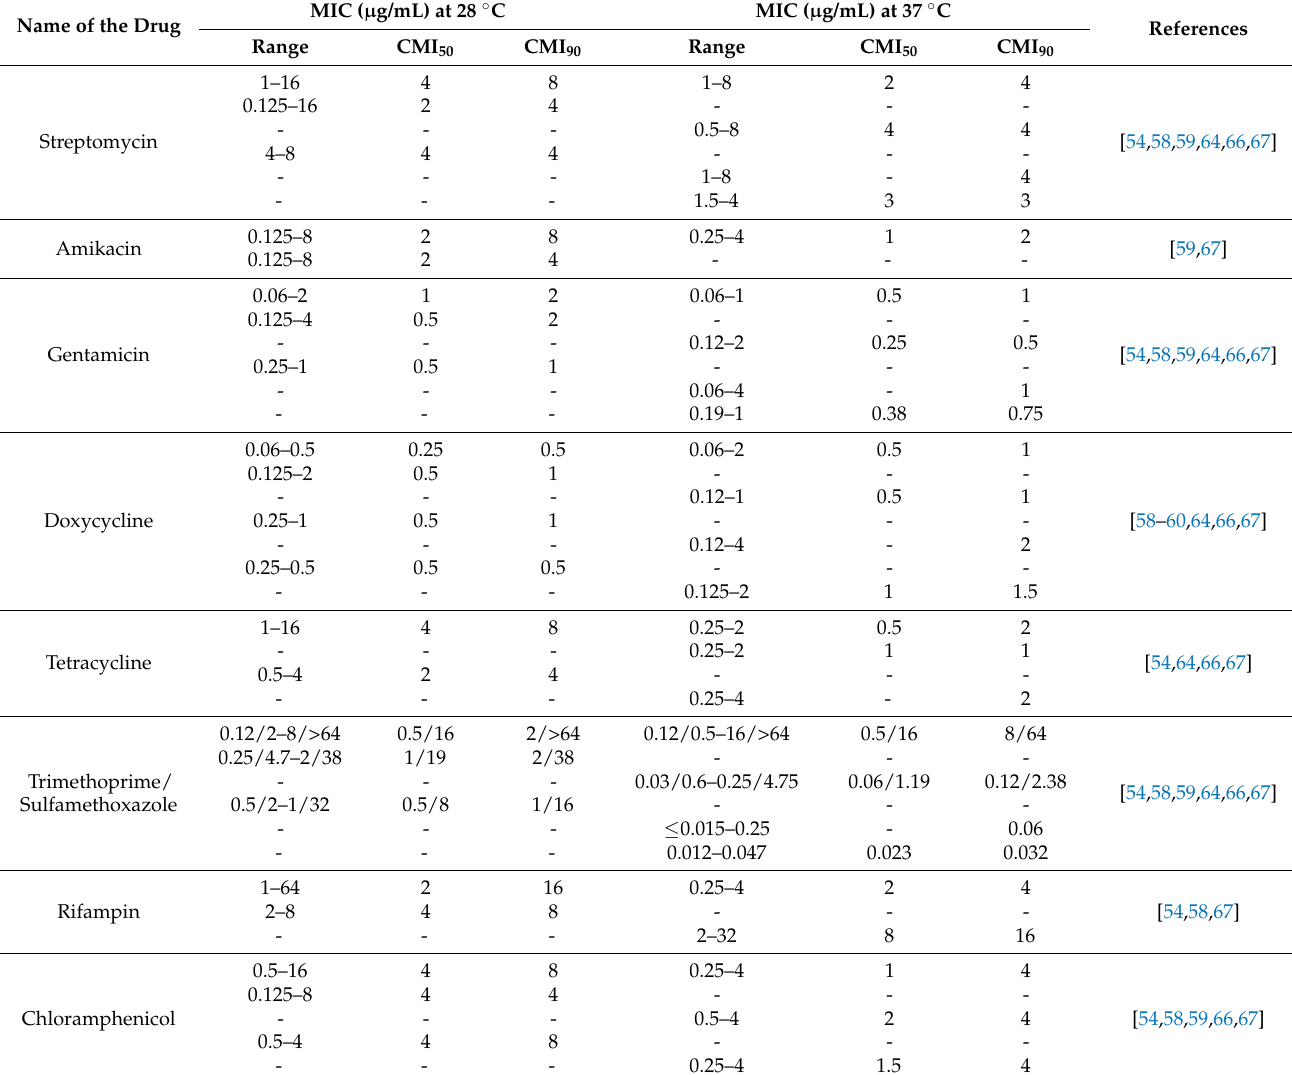
Table 1. Susceptibility of Yersinia pestis to conventional